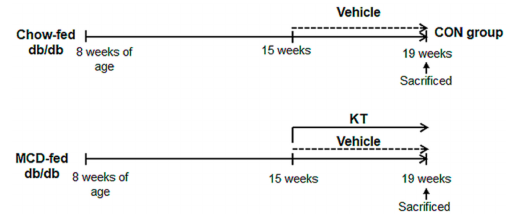
Figure 1. Design of mouse experimental model. After being fed with methionine / choline-deficient (MCD) for seven weeks, db / db mice were additionally treated with MCD for four weeks in parallel with oral administration of saline (M + V, n = 5) or Kombucha tea (KT) (M + K, n = 6). Chow-fed mice were treated with equal volume of vehicle (CON, n = 4).